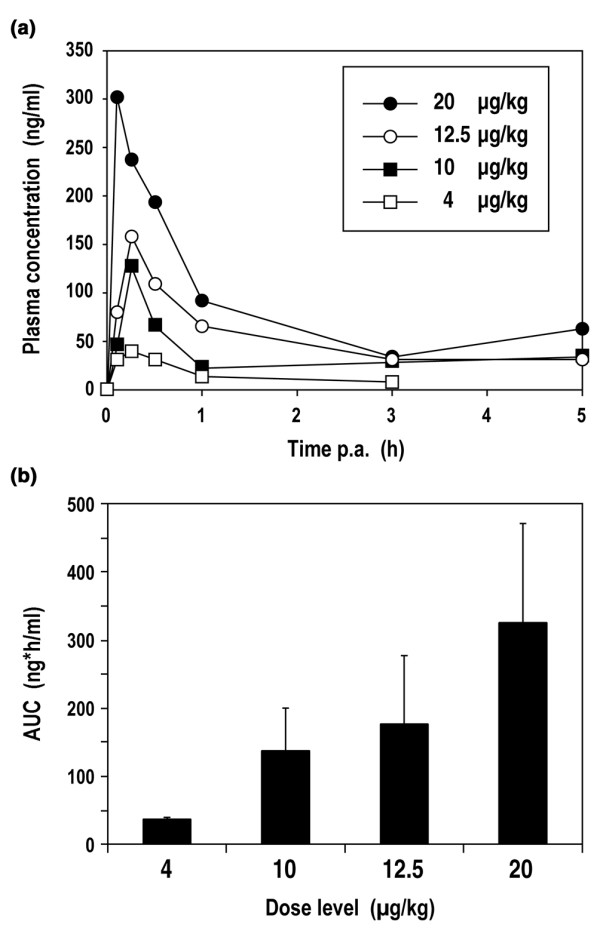
(a) Plasma levels of scFv(FRP5)-ETA at steady state. Plasma samples were taken from individual patients at each dose level at the indicated time points before and after infusion of scFv(FRP5)-ETA on treatment day 5. Plasma concentrations were determined by capture ELISA with 1:10 diluted plasma including standard scFv(FRP5)-ETA concentrations for quantification. No scFv(FRP5)-ETA was detected in the predose levels, indicating that no accumulation occurred with a once-daily dose interval. (b) Area under the concentration–time curve (AUC0–5 hours) at steady state on treatment day 5 for the different dose levels. The area under the concentration–time curve was calculated according to the trapezoidal rule from 0 to 5 hours. In accordance with the concentration-time profiles there was a dose-dependent increase of the area under the concentration–time curve, indicating linear pharmacokinetic behavior in the investigated dose range.